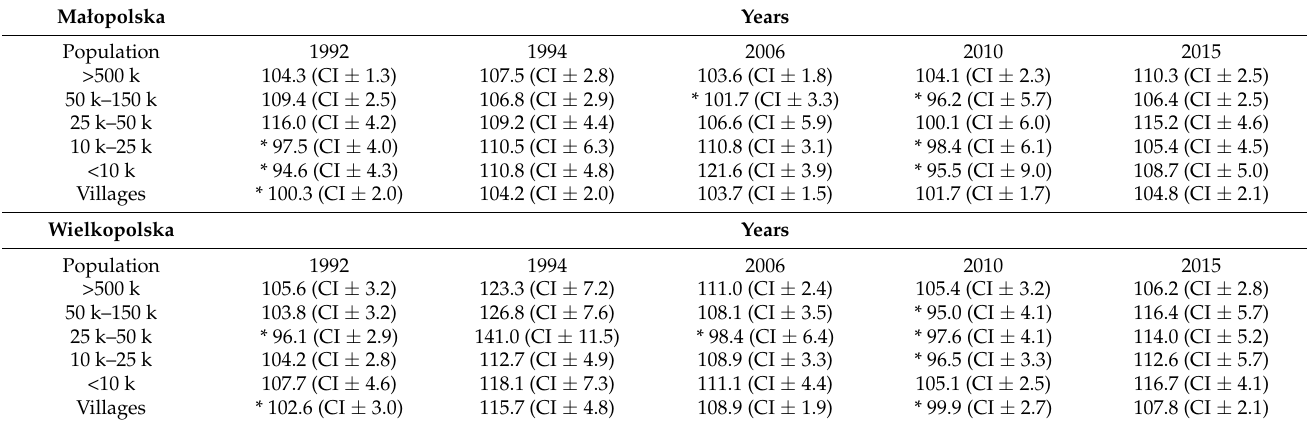
Table 7. Heat-related mortality during the five summer periods calculated as percentage of the expected number of deaths. The period between the first sub-wave and the thirtieth day after the end of the last sub-wave. Subpopulation age 65 and older is analyzed. The 90% confidence intervals are in brackets. Statistically insignificant results are marked with